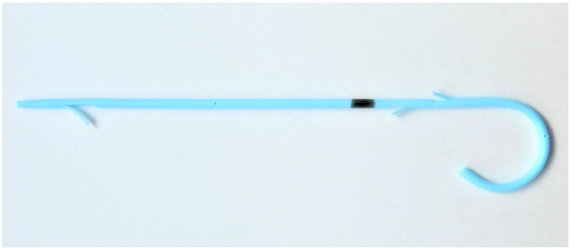
Figure 1:. 4-Fr pancreatic stent. The stent has a tapered tip, three internal flanges (one at the distal end and two at the proximal end), and a single external pigtail with a black marker on the proximal